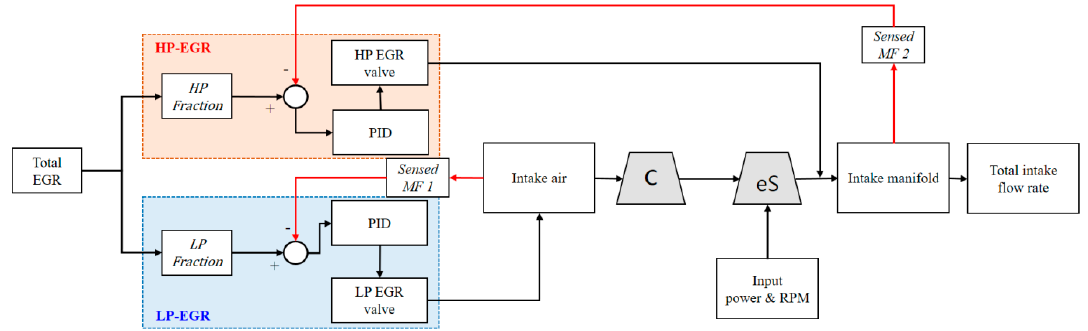
Figure 4. Overall control scheme of the dual-loop exhaust gas recirculation (EGR) and electric supercharger (eS) systems.